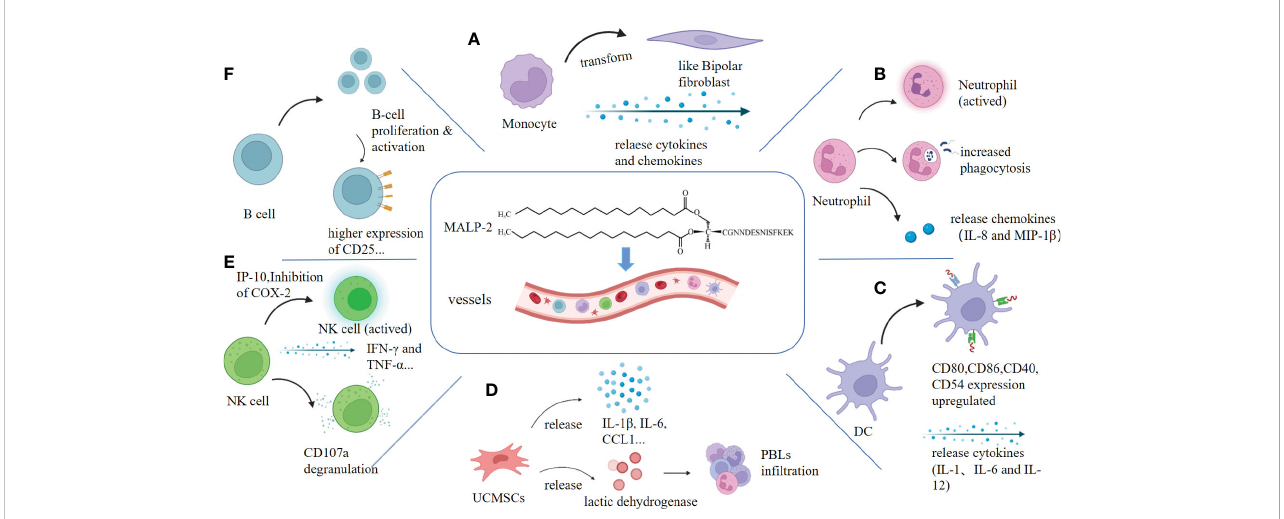
FIGURE 1 MALP-2 activates immune cells. Clockwise: (A) MALP-2 activated monocytes release cytokines and chemokines, causing monocytes to exhibit a bipolar fi broblast-like morphology. (B) MALP-2 enhanced the phagocytosis of PMN and activated PMN to secrete IL-8 and MIP-1 b . (C) MALP-2 induced dendritic cells to release cytokines and stimulated upregulation of expression of co-stimulatory molecules and others. (D) MALP-2 activated NK cells to release IFN- g and TNF- a in the presence of COX-2 inhibitors, enhancing CD107a degranulation from NK cells. (E) MALP-2 induced the release of cytokines and